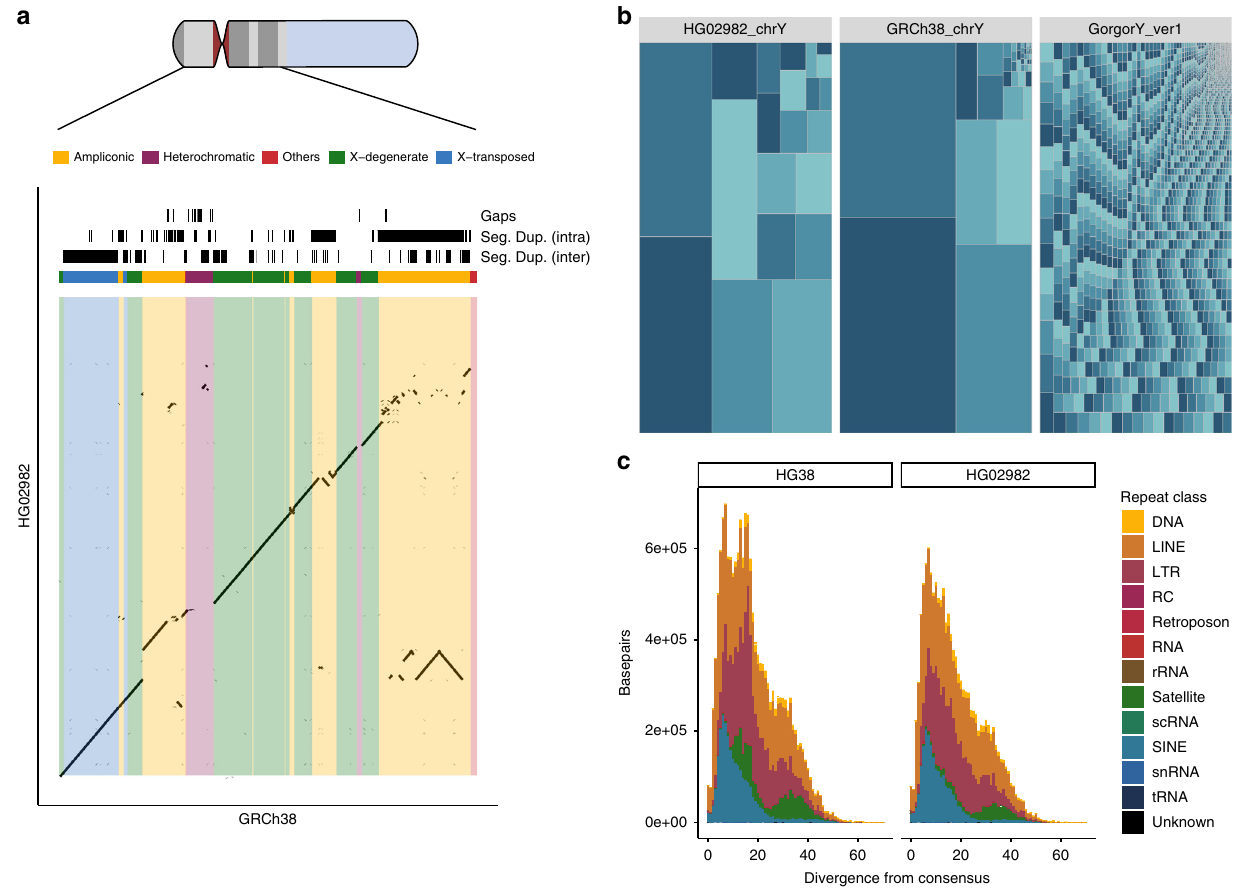
Fig. 2 Chromosome-Y assembly overview and comparisons. a Dot-plot comparing the resolved MSY of GRCh38 with HG02982. The reconstruction is highly continuous along most sequence classes, with ampliconic regions showing a higher degree of fragmentation. Seg. Dup. (intra) refers to intra- chromosomal segmental duplications, Seg. Dup. (inter) refers to inter-chromosomal segmental duplications. Altogether, ~ 50% of the of the Y chromosomes resolved sequence space in GRCh38 — > 13 Mb — are annotated as segmental duplications. b Treemap comparing the contiguity of HG02982 chrY with GRCh38 chrY and the gorilla Y chromosome by Tomaszkiewicz et al. The size of each rectangle corresponds to the size of a contig within each of the assemblies. Neighboring rectangles are colored differently as a visual aid. c Repeat landscape of common, interspersed repeats annotated equally in GRCh38 and HG02982. Common repeats — including very recent ones — are well resolved in HG02982. The exception are satellite sequences, and a population of somewhat divergent (~ 20%) LTR elements, which are absent in HG02982 (see supplementary Figures 7-9). Source data are provided